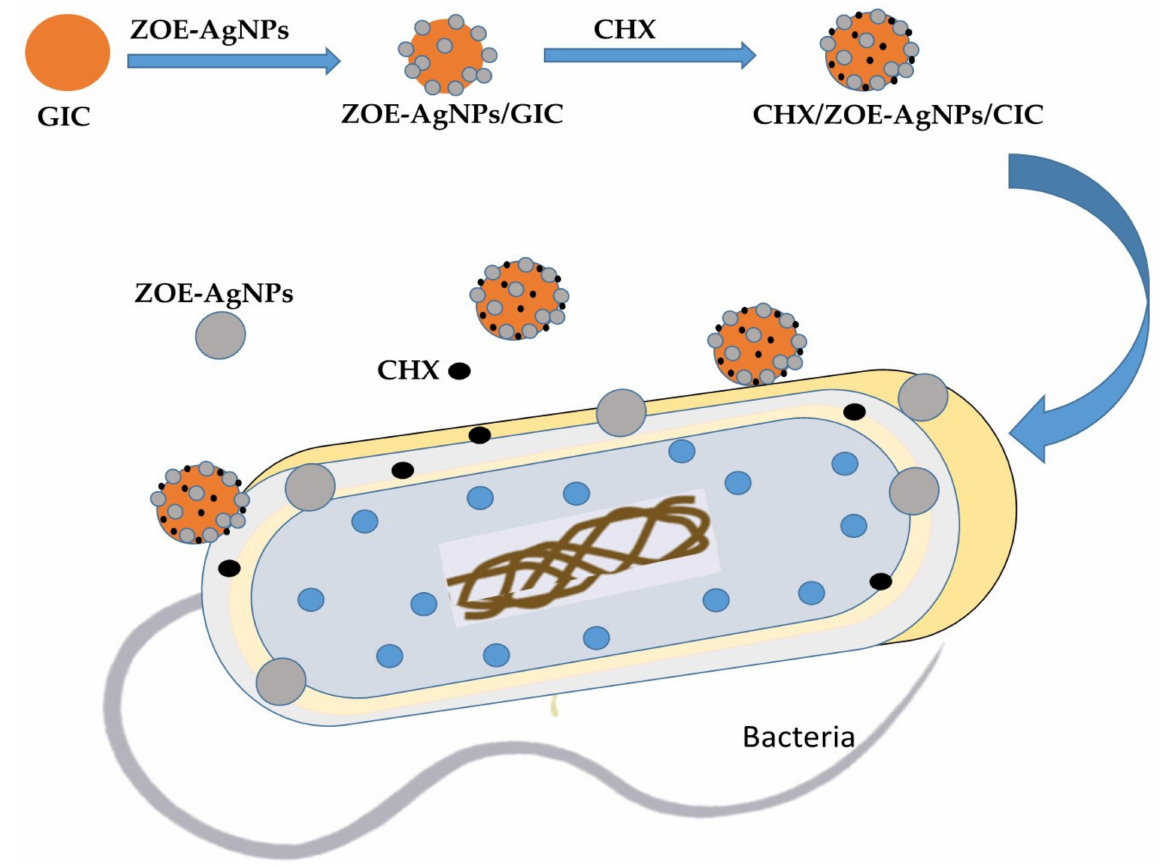
Scheme 1. Schema of synthetic diagram for ZOE-AgNPs/CHX/GIC and their synergistic antimicro- bial